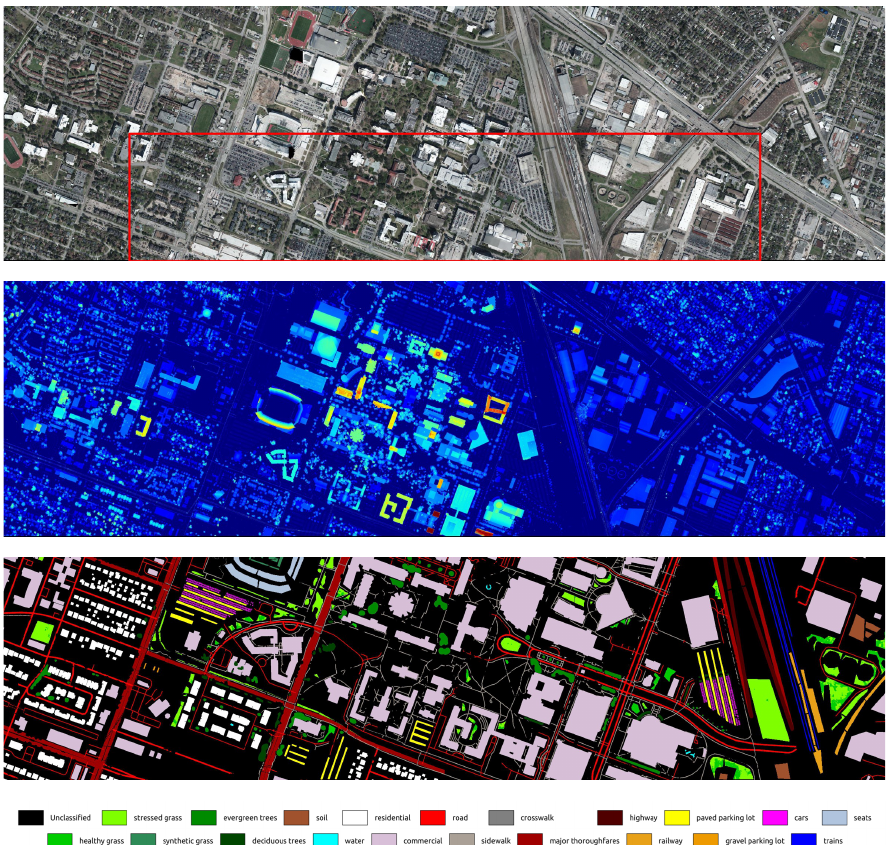
Figure 12. DFC2018 dataset. The top image is the optical image in the dataset, the middle image is the relative height image, and the bottom image is the semantic segmentation image provided by the dataset, which has 20 categories. In particular, the semantic segmentation image only provides the ground feature classification map of 4 of the 14 optical images. The bottom ground feature classification map in the map corresponds to the optical image with the top red